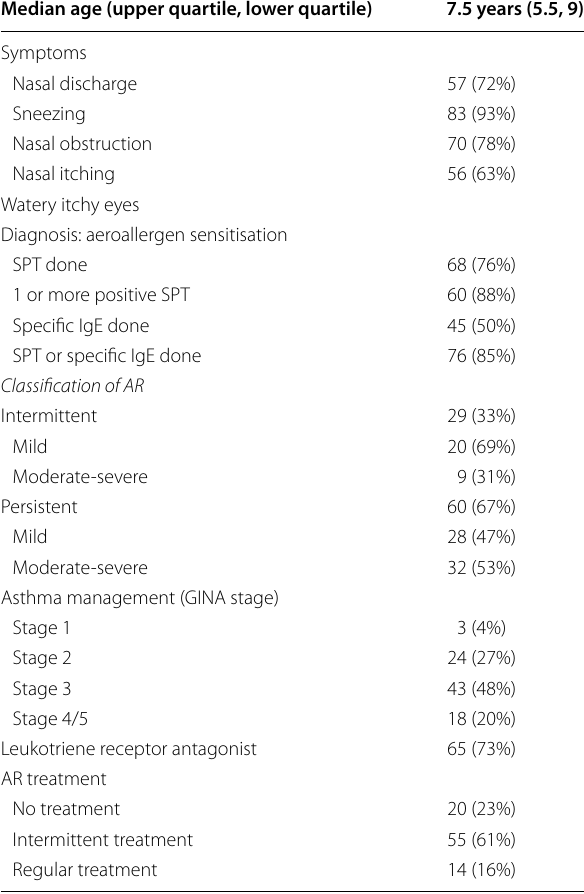
Table 1 Clinical features of children with allergic